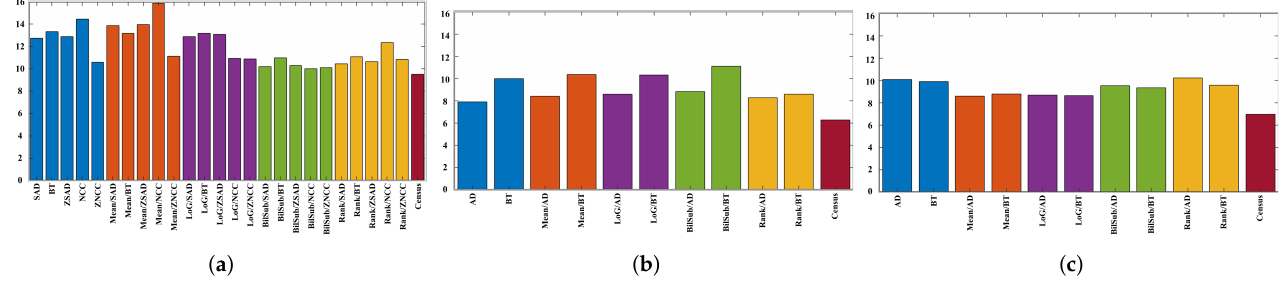
Figure 5. Mean errors on the combinations of the cost and image filters, according to each stereo matching method over the synthetic active dataset. The attributes of the active IR images were set to default values. Each color represents different filters along the methods. ( a ) Window-based. ( b ) SGM. ( c )